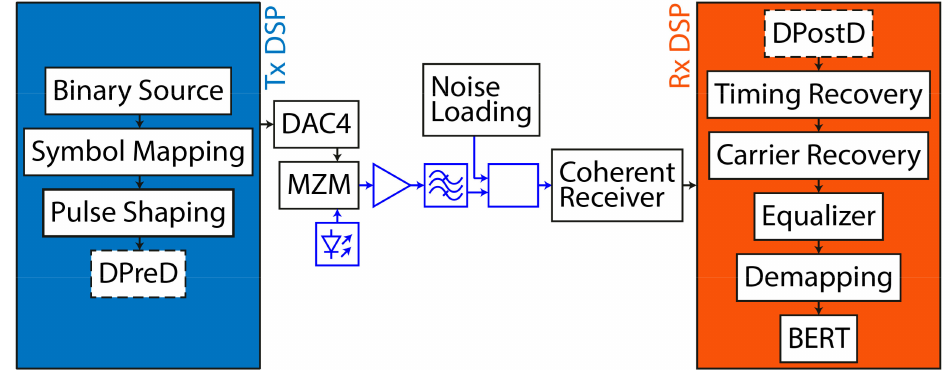
Figure 5. Overview of digital signal processing (DSP) and experimental set-up. The optical path is indicated by the blue color. Tx: transmitter; MZM: Mach–Zehnder modulator; Rx: receiver; BERT: bit error ratio